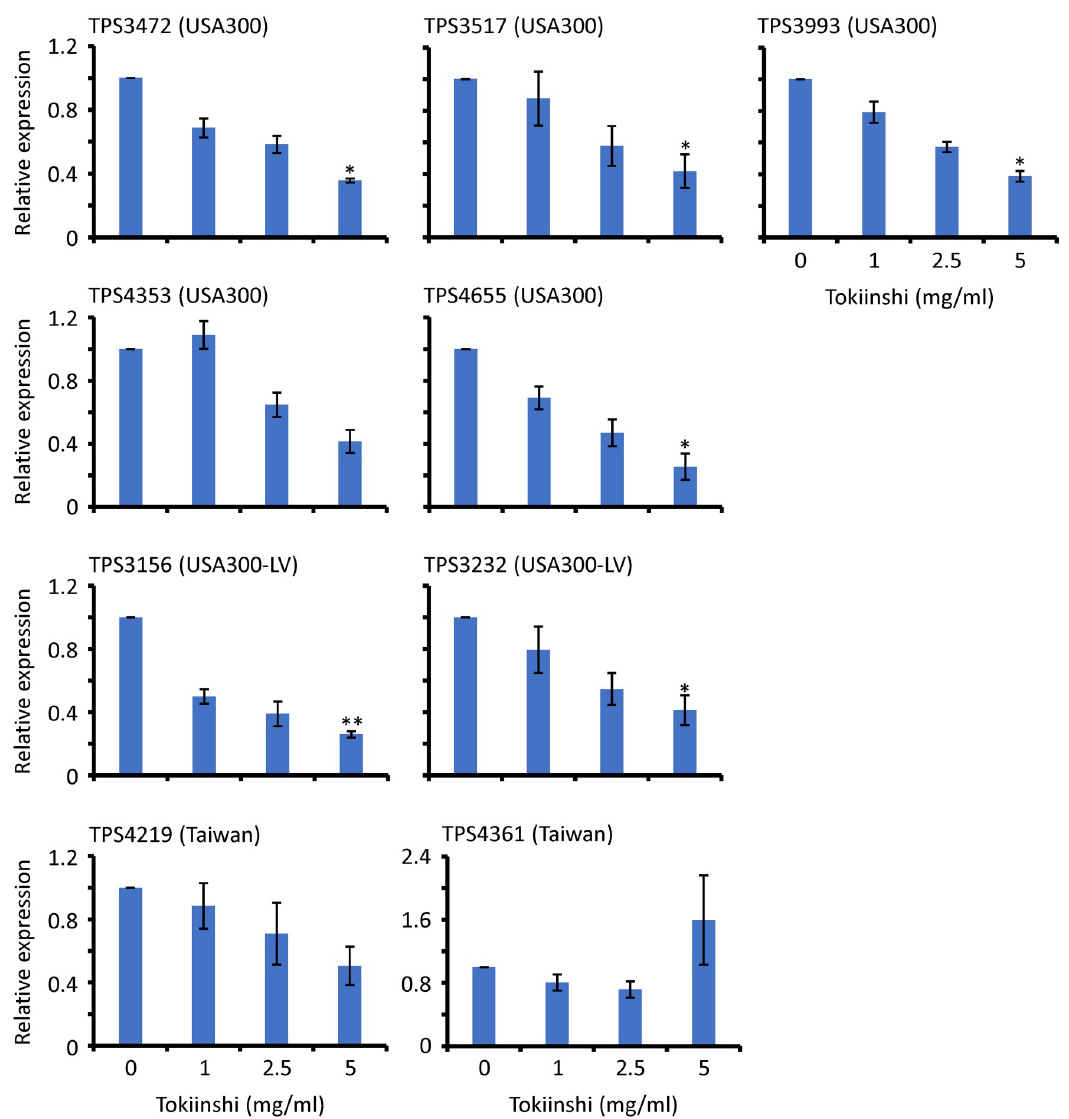
Fig 4. PVL gene expression in the presence and absence of Tokiinshi. � P < 0.05 and �� P < 0.01 vs. 0 mg/ml.